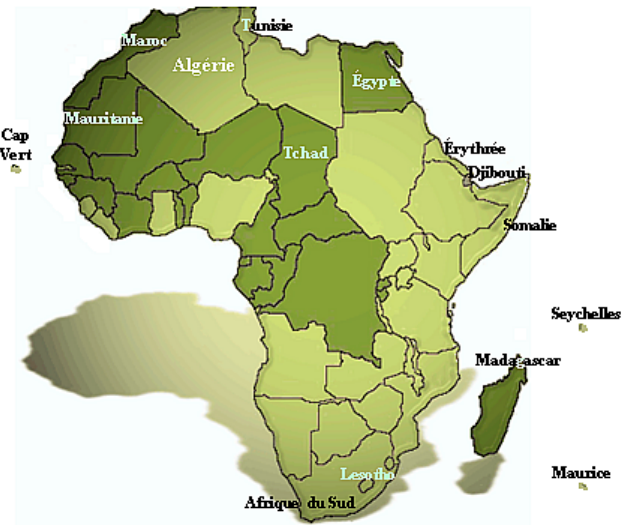
Figure 2. Geographical map of Algeria.